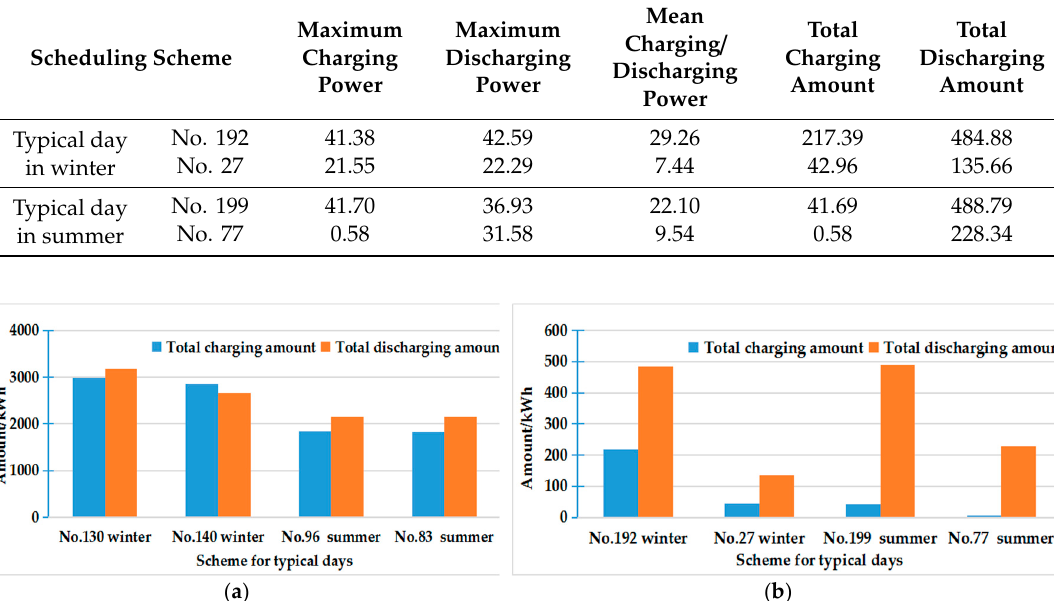
Figure 16. Comparison of total charging/discharging amount. ( a ) VESS of RFHCS; and ( b ) VESS of CHCS. Table 15. Performance of the VESS of RFHCS for the typical days in winter/summer.